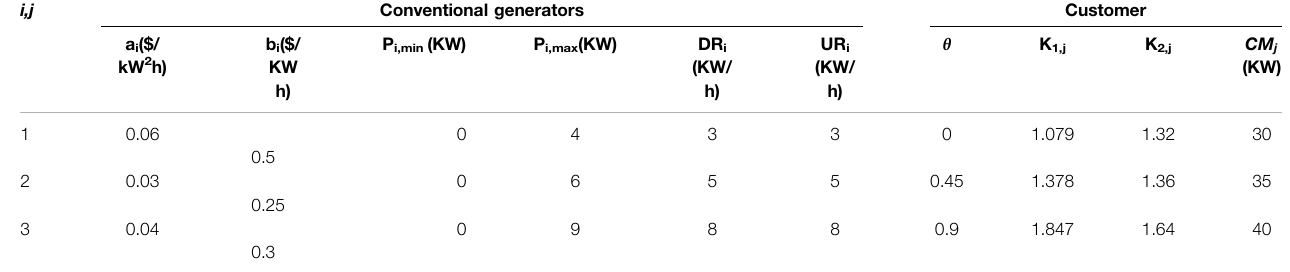
TABLE 2 | Conventional generators and customers data (case study 1).